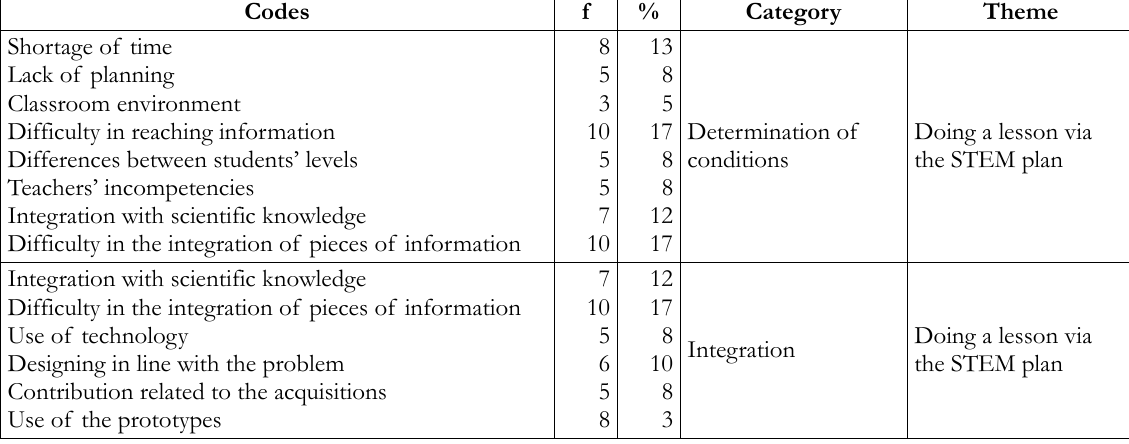
Table 3. Results belonging to the analysis of the second question including difficulties which are likely to be encountered while teaching lessons in accordance with the STEM lesson